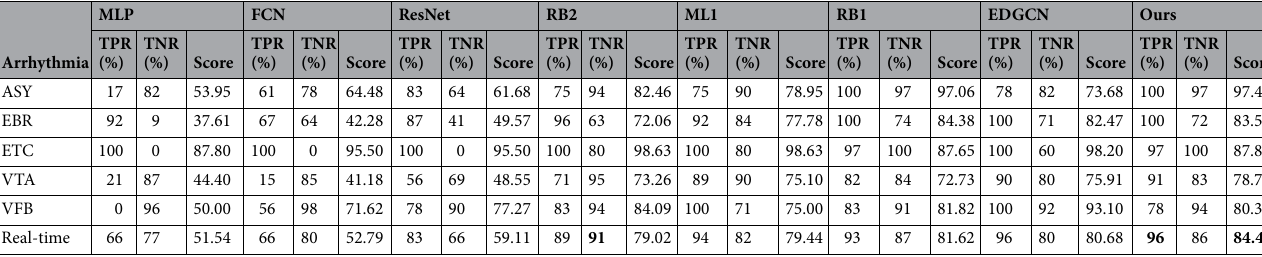
Table 2. Performance comparison on the test set of PhysioNet Challenge 2015. Best performing values in each performance metric are given in bold.